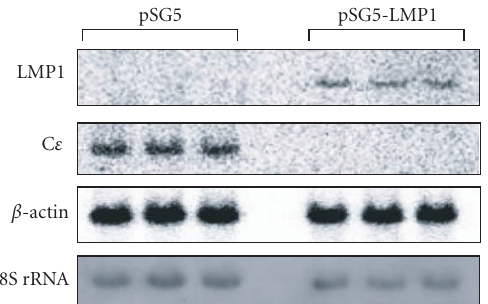
Figure 3: E ff ect of LMP1 expression on C ε mRNA levels of spleno- cytes derived from BN rats immunized with DNP-As. The pSG5- LMP1 or empty vector was transfected into the splenocytes derived from BN rats immunized with DNP-As using lipofecton method. LMP1 and C ε mRNA expression were determined by Northern blot analysis as described in the “materials and methods.” The results of three independent experiments are